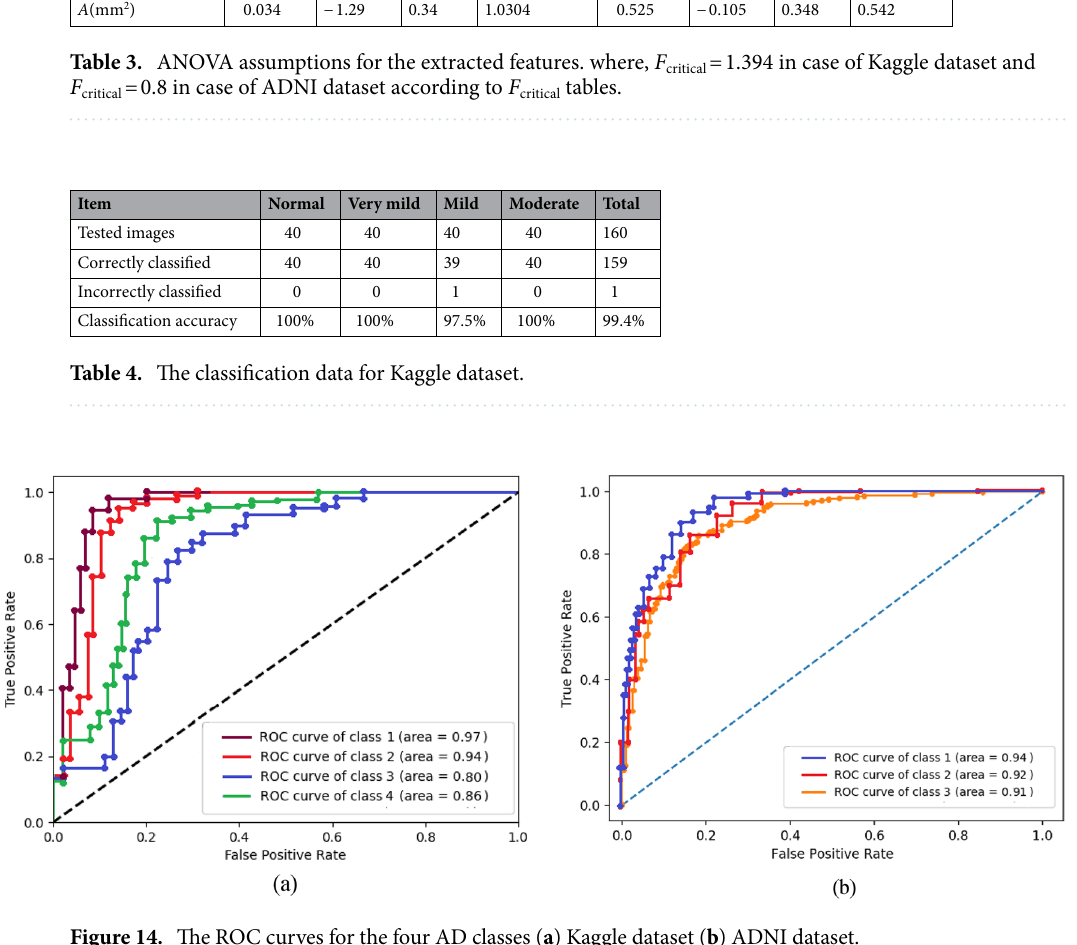
Figure 14. The ROC curves for the four AD classes ( a ) Kaggle dataset ( b ) ADNI dataset.